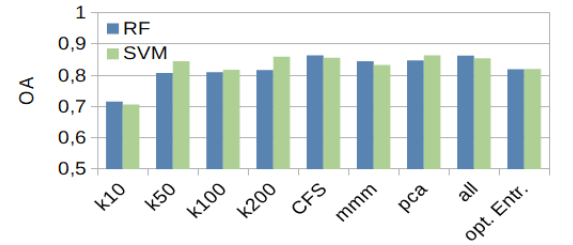
Figure 6. Overall Accuracy - kNN neighbourhood